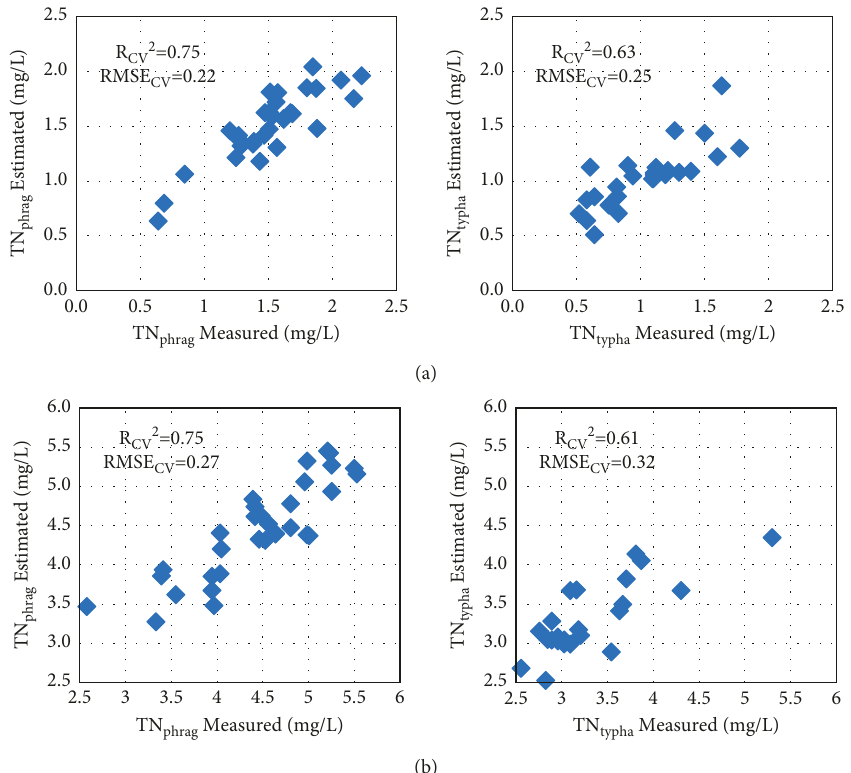
Figure 3: Relationship between measured values and estimated values in cross validation of SMLR model for TN content in water (a) and TN content in plants